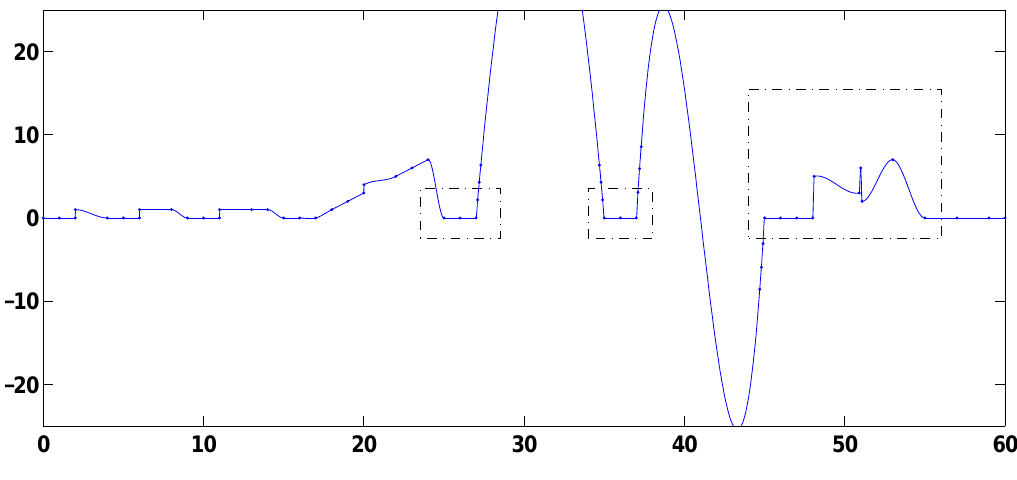
Figure 7 . First-derivative-based global L